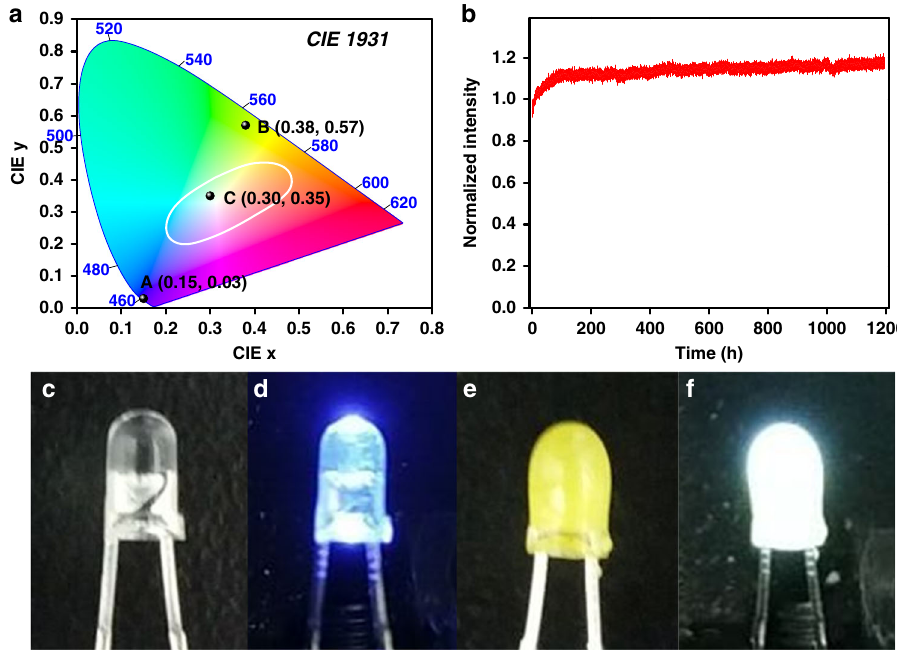
Fig. 5 Characterization and photographs of the LEDs. a CIE-1931 chromaticity diagram and the positions (marked by the dots) for blue LED (0.15, 0.03; a 3D-TPE-COF (0.38, 0.57; b ( λ ex = 450 nm), and COF-coated LED (0.30, 0.35; ( c ). b Normalized luminescence intensity vs. time curve of the 3D-TPE-COF- coated WLED driven at 2 mA. Photographs of the LEDs: c a reference blue LED (not turned on), d the reference blue LED turned on (emission with blue light), e the same LED coated with a thin layer of 3D-TPE-COF (not turned on), and f the coated LED turned on (emission with white